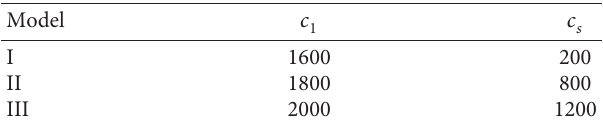
Table 4: Simulation models with different wave speeds in the seabed (unit: